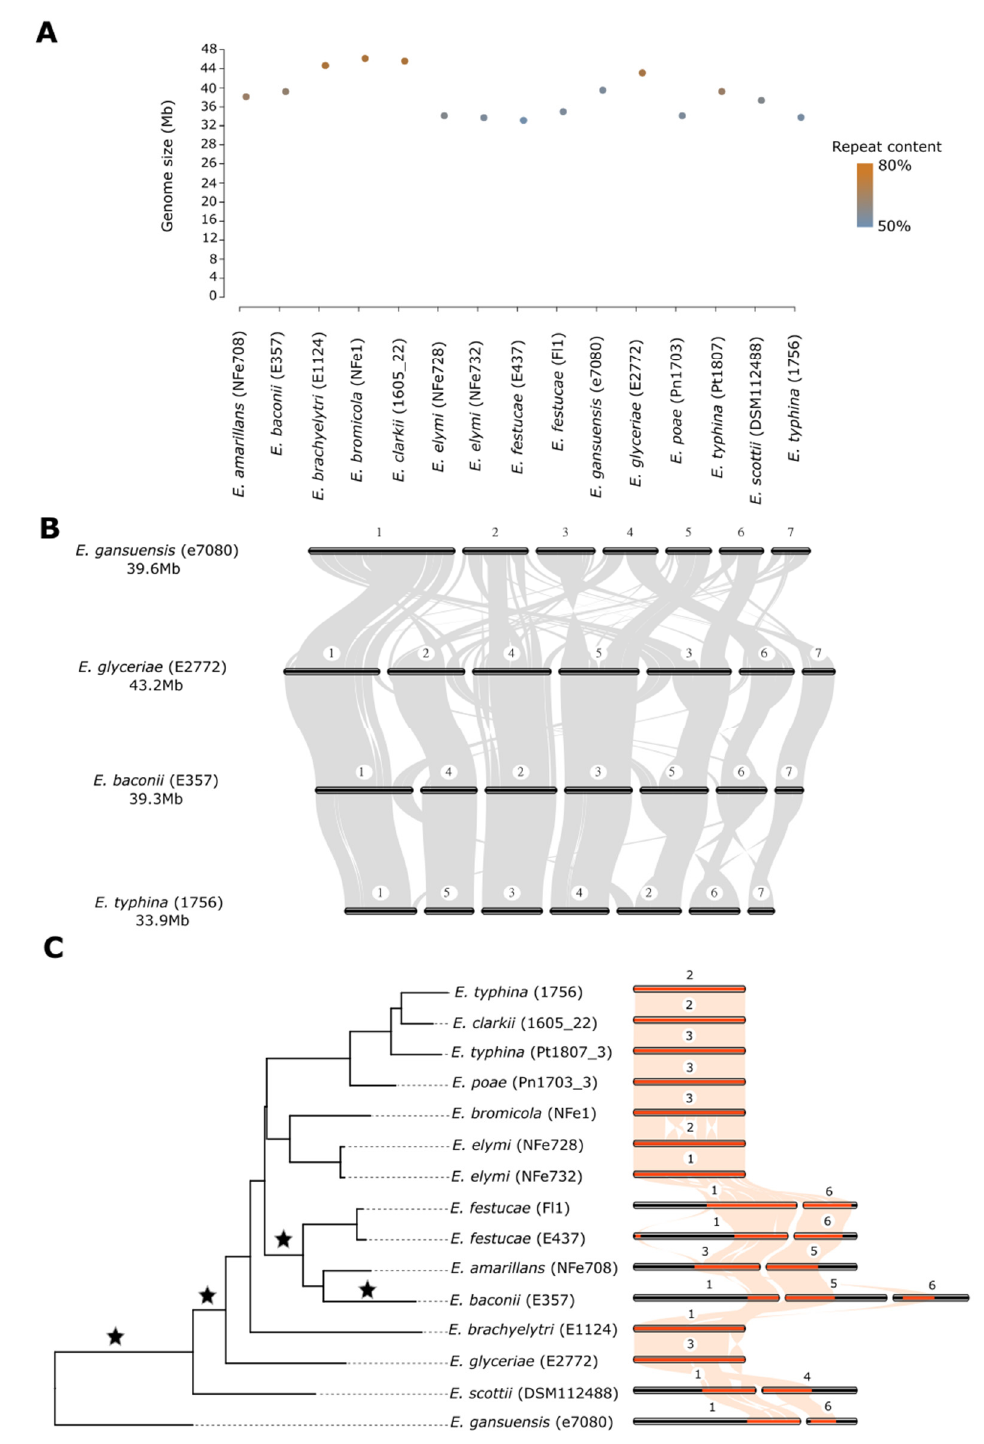
Figure 1. ( A ) Genome sizes for 15 Epichloë strains. The color of points indicates the repeat element content (%) of each genome. ( B ) Genome-wide rearrangements between four Epichloë species, inferred from gene-based syntenic analysis. Chromosomes are numbered relative to their size within each species, as the extensive rearrangements prevent homology-based numbering. ( C ) Evolutionary restructuring of a representative chromosome across the genus Epichloë . Sequences homologous in gene content to chromosome 2 in E. clarkii are highlighted in orange. Stars indicate positions in the phylogeny where major inter-chromosomal rearrangements have occurred. The chromosome numbers for each species are indicated.